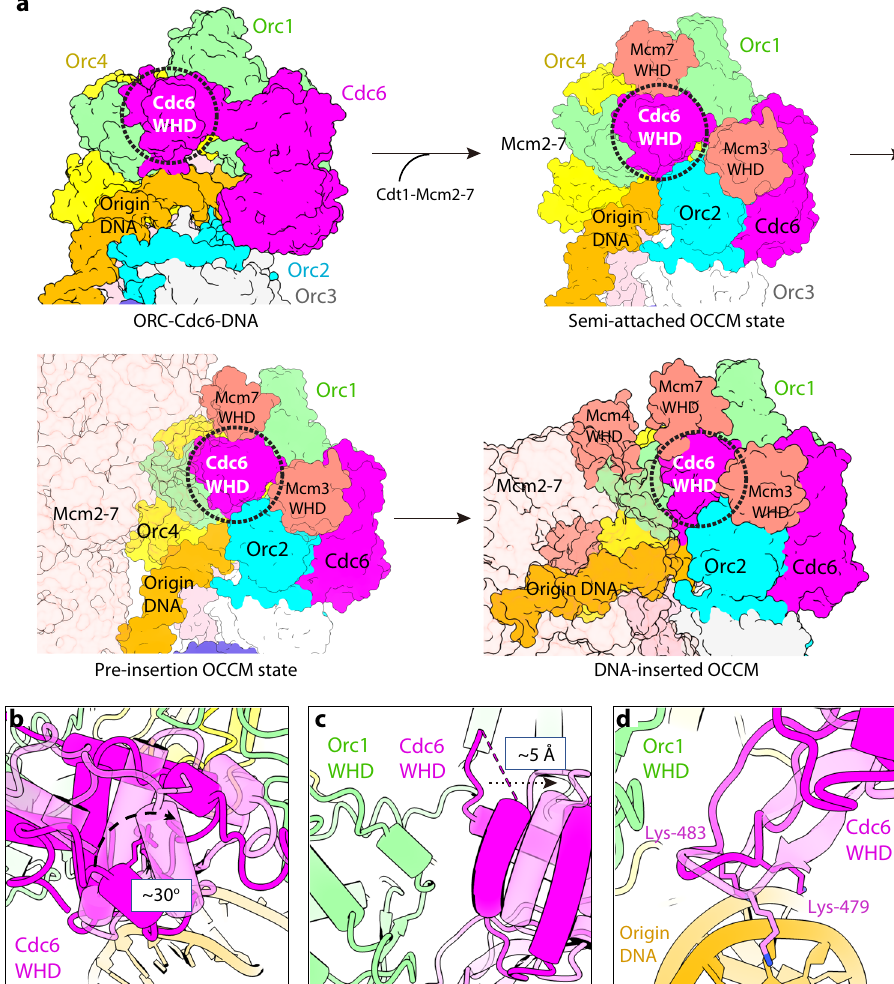
Fig. 6 The Cdc6 WHD undergoes multiple conformational changes from ORC – Cdc6 to OCCM during the loading of the Mcm2-7 hexamer. a Conformational changes of the Cdc6 WHD during the loading of Mcm2-7 from ORC – Cdc6 to semi-attached OCCM to pre-insertion OCCM and to the DNA-inserted OCCM. The dashed black circle in the last panel encircles the Cdc6 WHD binding region; this region is enlarged in panels ( b – d ) and shown in different views. b , c The Cdc6 WHD rotates ( b ) and shifts ( c ) relative to the Orc1 AAA + domain. d The repositioned Cdc6 WHD in OCCM inserts Lys- 479 and Lys-483 into the now straightened ACS DNA groove. In panels ( b – d ), the Cdc6 WHD is shown as solid purple in the ORC – Cdc6 and as transparent purple in the OCCM